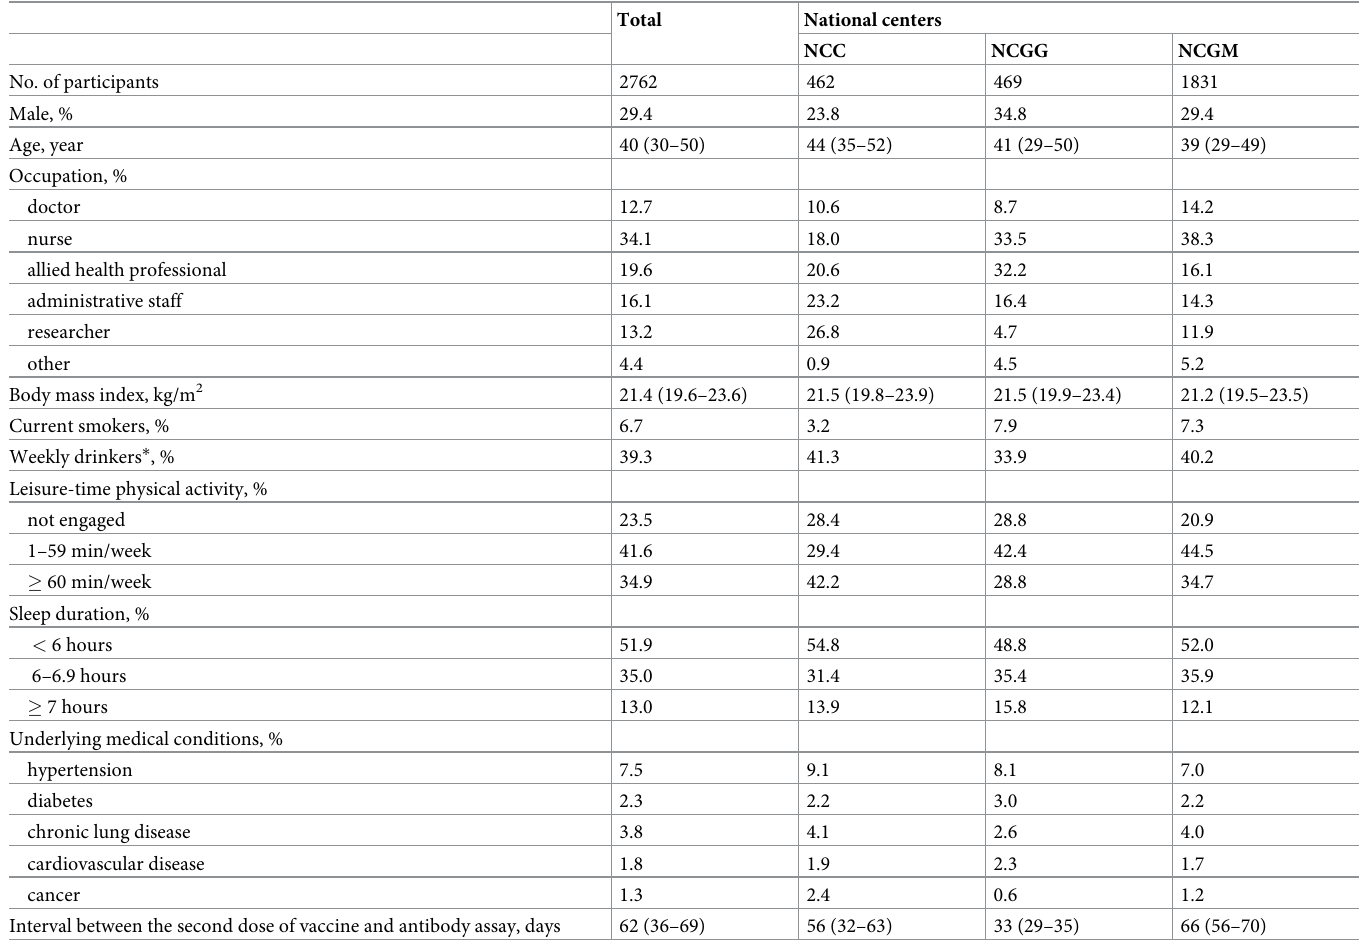
Table 1. Participants’ characteristics according to three national